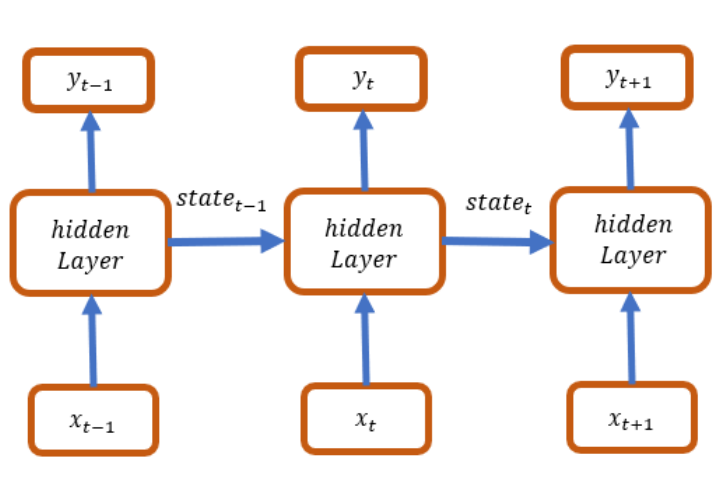
Figure 4. RNN structure.